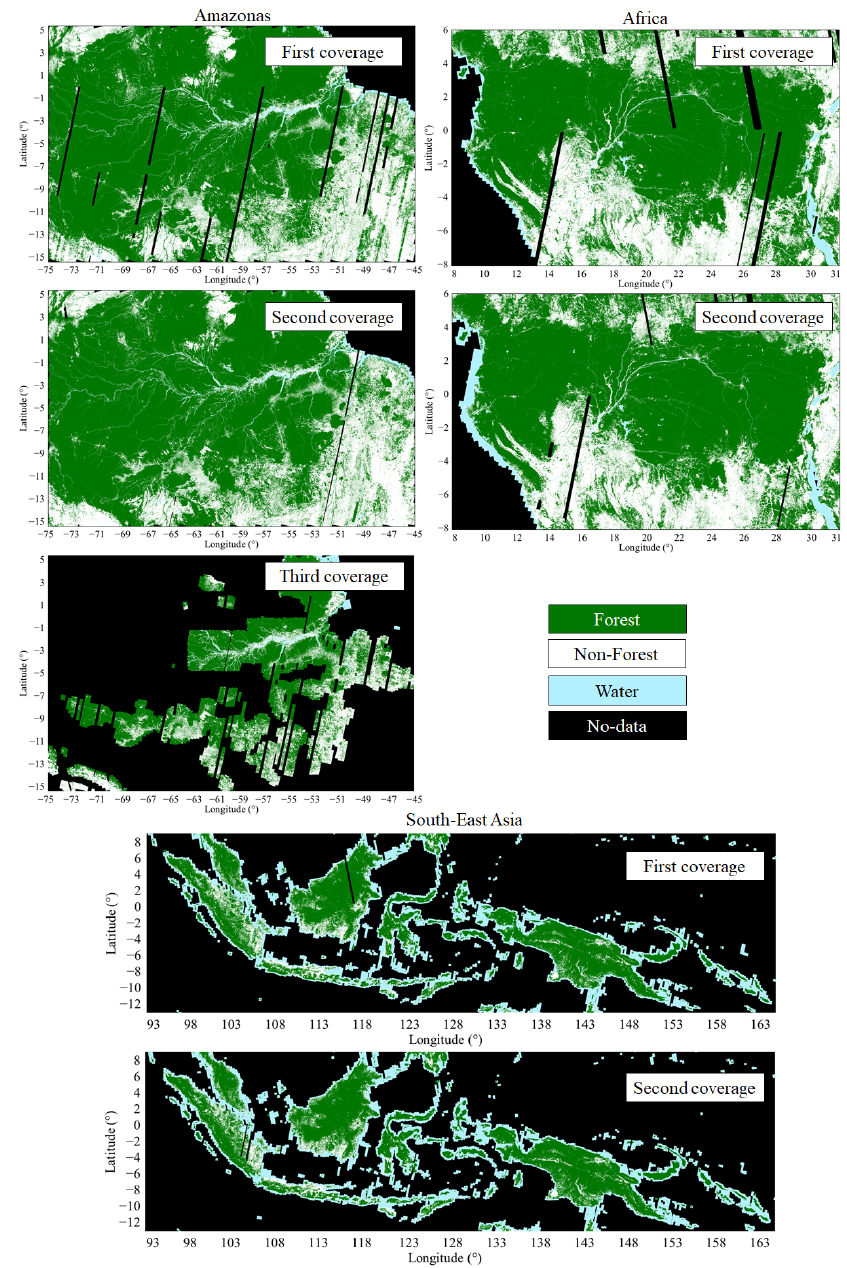
Figure 8. Large-scale forest/non-forest mosaics over the tropical regions (Amazonas, Africa and Indonesia) generated from the first, second and third coverages (where available) of the TanDEM-X